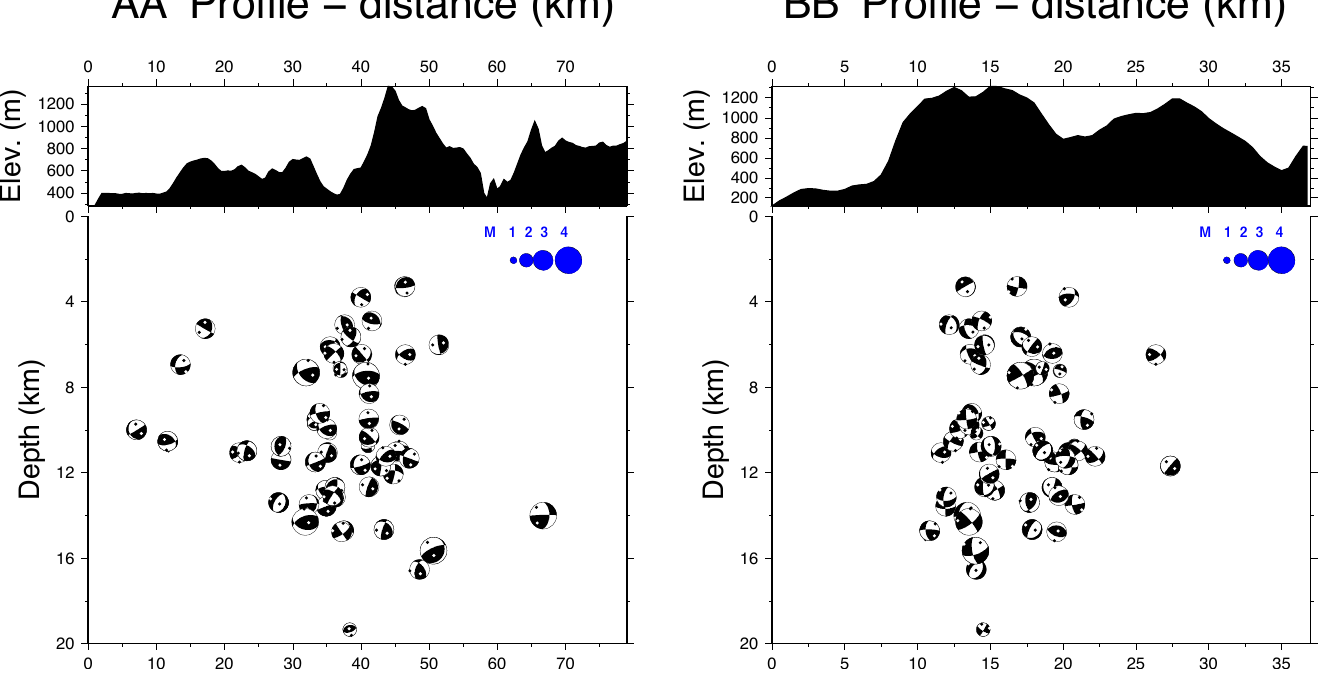
Figure 4. Vertical sections along the AA’ (a) and BB’(b) profiles from Figure 3, showing the fault plane solutions obtained by selecting aftershocks recorded at more than 15 stations. The sizes of the focal spheres are proportional to the magnitudes of the event (see blue balls scale). Next page: Figure 5 (top). Coverage of ray paths used for travel-time inversions. Left panel: map of the first layer (depth range — 1 km to 1 km, because of the presence of topography, characterized by an average elevation of 1 km). Right panels: vertical sections along BB’ (upper plot) and EE’ (lower plot). White triangles, locations of the seismic stations. Figure 6 (bottom). Checkerboard tests, comparing the true (left panels) and the reconstructed (right panels) velocity models in the second layer (upper panels) and two vertical sections, along AA’ (middle panels) and BB’ (lower